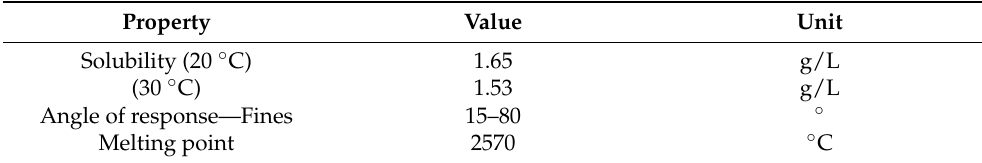
Table 5. Hydrated lime properties Reprinted from ref. [15].